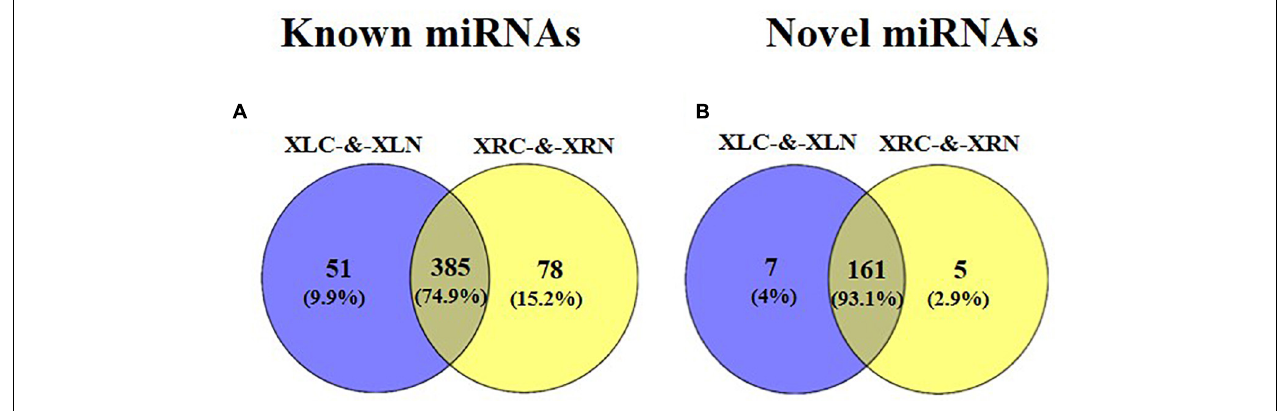
FIGURE 2 | Distribution of known and novel miRNAs in roots and leaves of “Xushu 22.” (A) Known miRNAs in roots and leaves; (B) Novel miRNAs in roots and